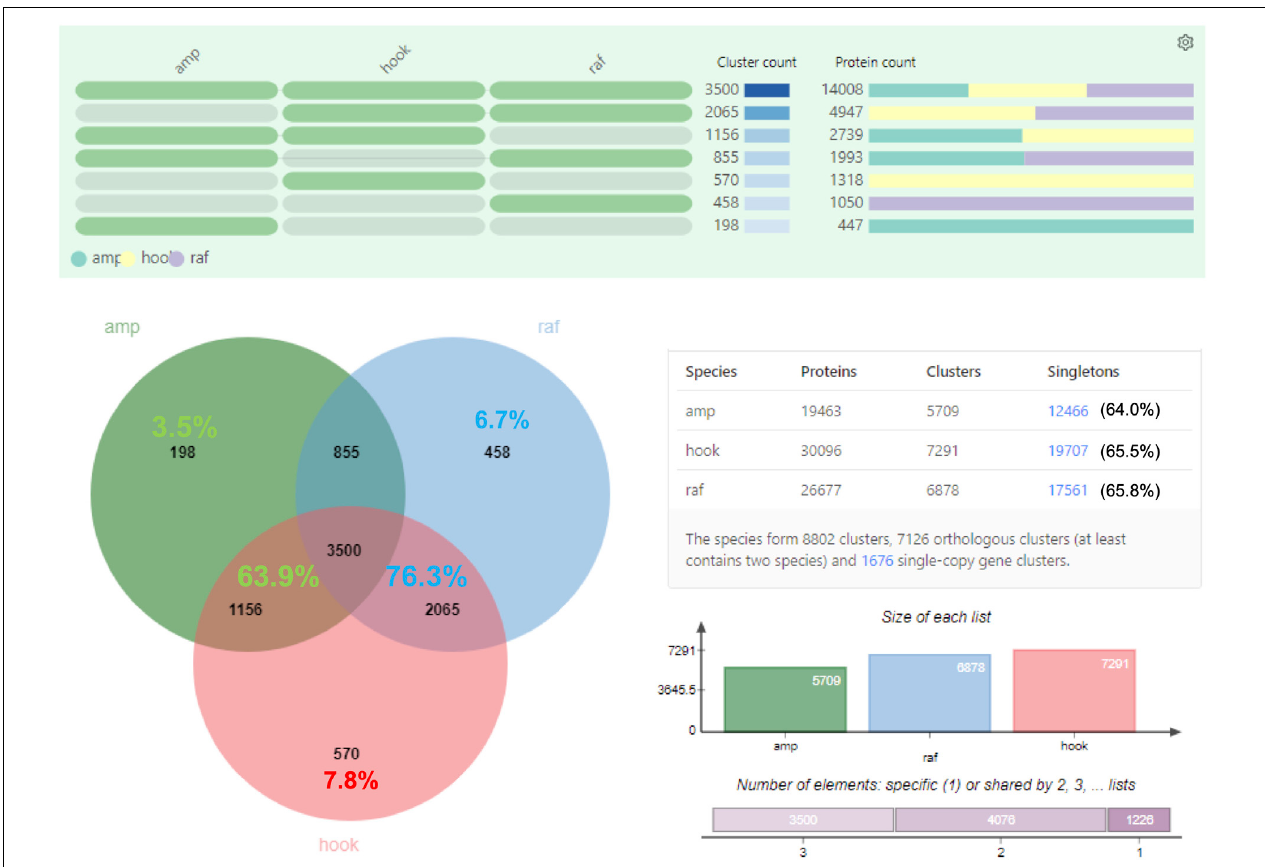
FIGURE 2 | OrthoVenn analysis on the distribution of orthologous protein clusters of predicted protein sequences. Top part shows the cluster and protein counts in different sections of the Venn diagram, which shows the number of protein clusters. Percentages in the shared regions of Venn diagram between the hybrid and parents are calculated based on the total clusters in the hybrid; the percentages in the non-shared sections are based on respective species. The table on the lower right summarizes the numbers of proteins, clusters, and singletons in each species. Singletons are protein sequences that do not form any cluster with other sequences and are shown with percentages out of total number of protein sequences in the respective species. The charts on the lower right show the size of protein clusters in each species and the cumulative numbers of shared elements based on the Venn diagram. amp: N . ampullaria ; raf: N . rafflesiana ; hook: N . × hookeriana